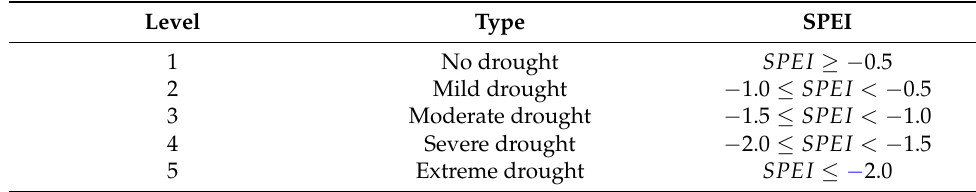
Table 2. Drought classification based on